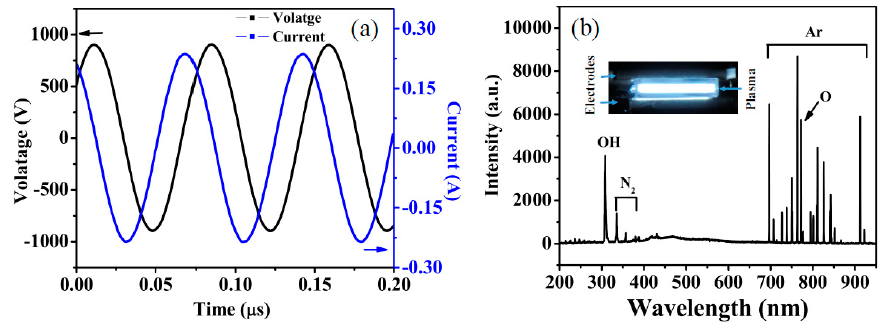
Figure 2. ( a ) Voltage and current waveforms of argon RF discharge of 80 W; ( b ) OES spectrum of argon RF discharge.